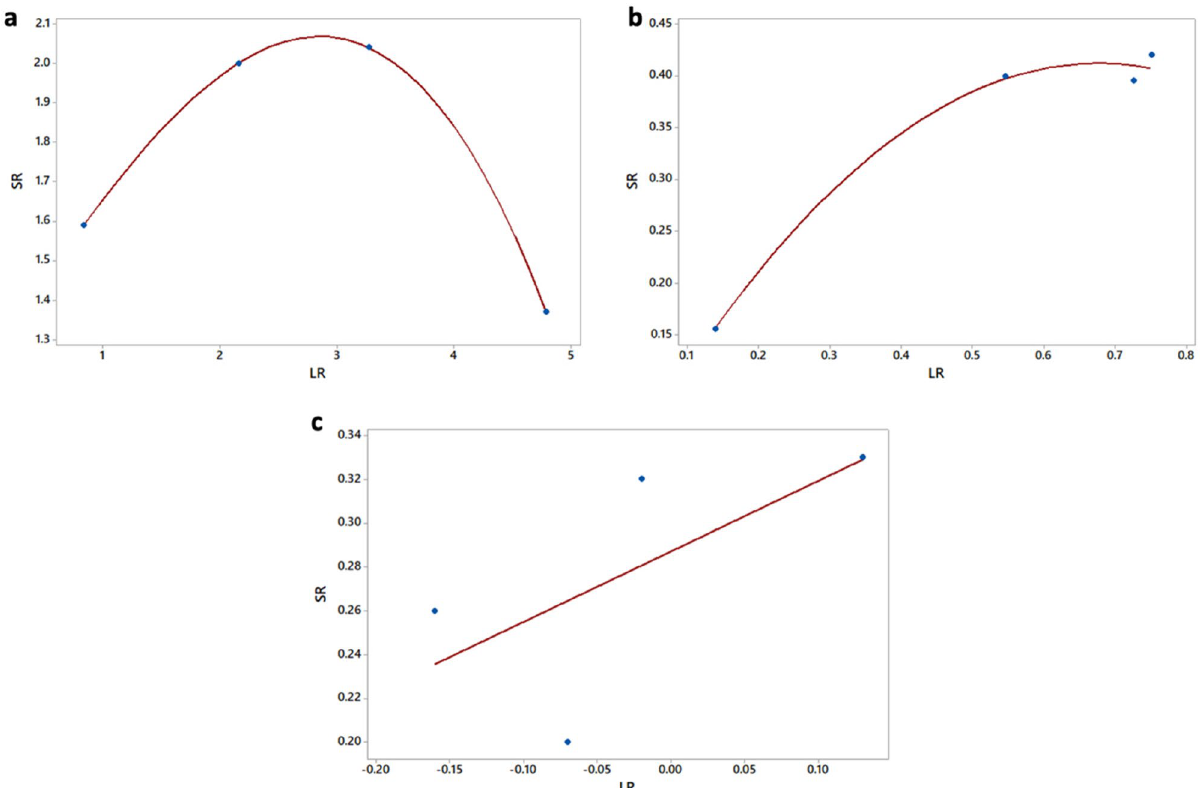
Figure 3. Reproducibility curves. Reproducibility SD (S R ) calculated as a function of the mean log reduction (LR) for all 4 concentrations of NaOCl across all 5 labs. ( A ) Plate count, ( B ) Resazurin, ( C ) Crystal